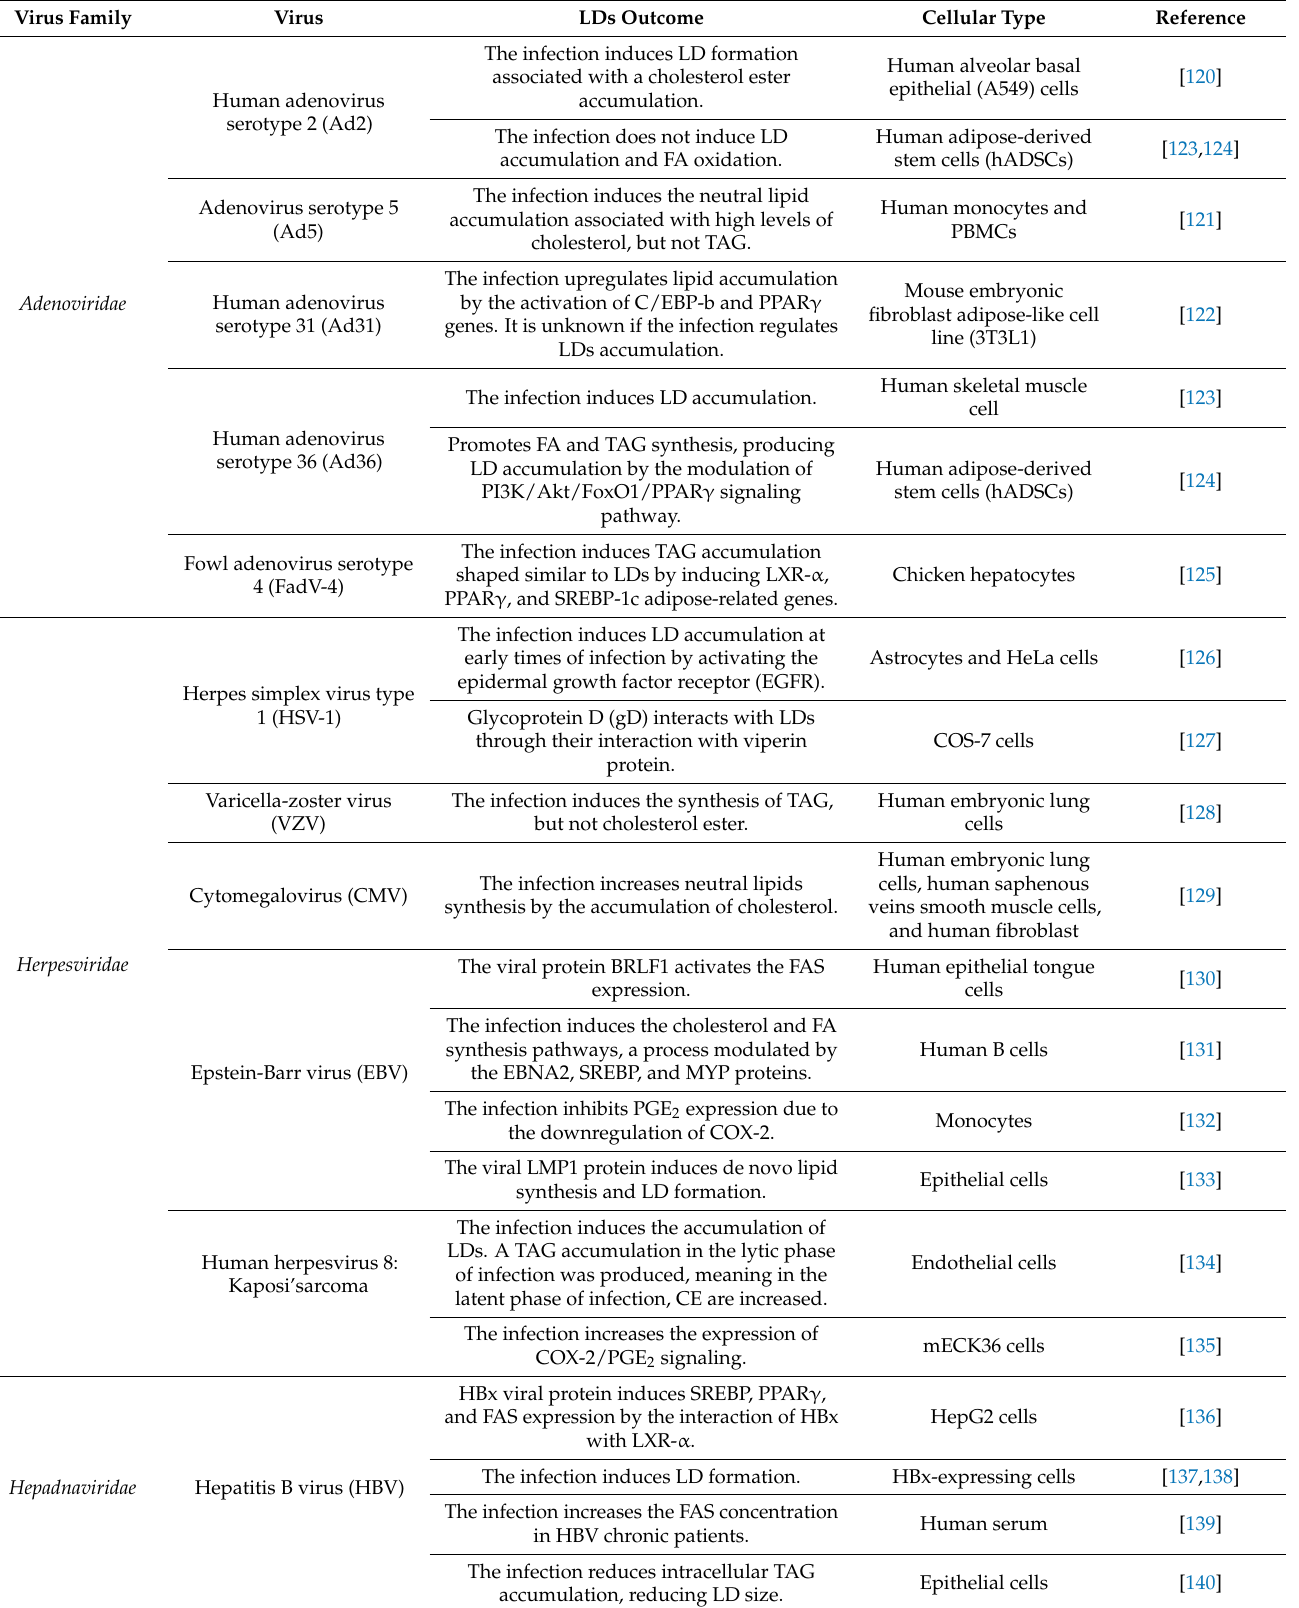
Table 1. Modulation of lipid metabolism and LD synthesis by DNA